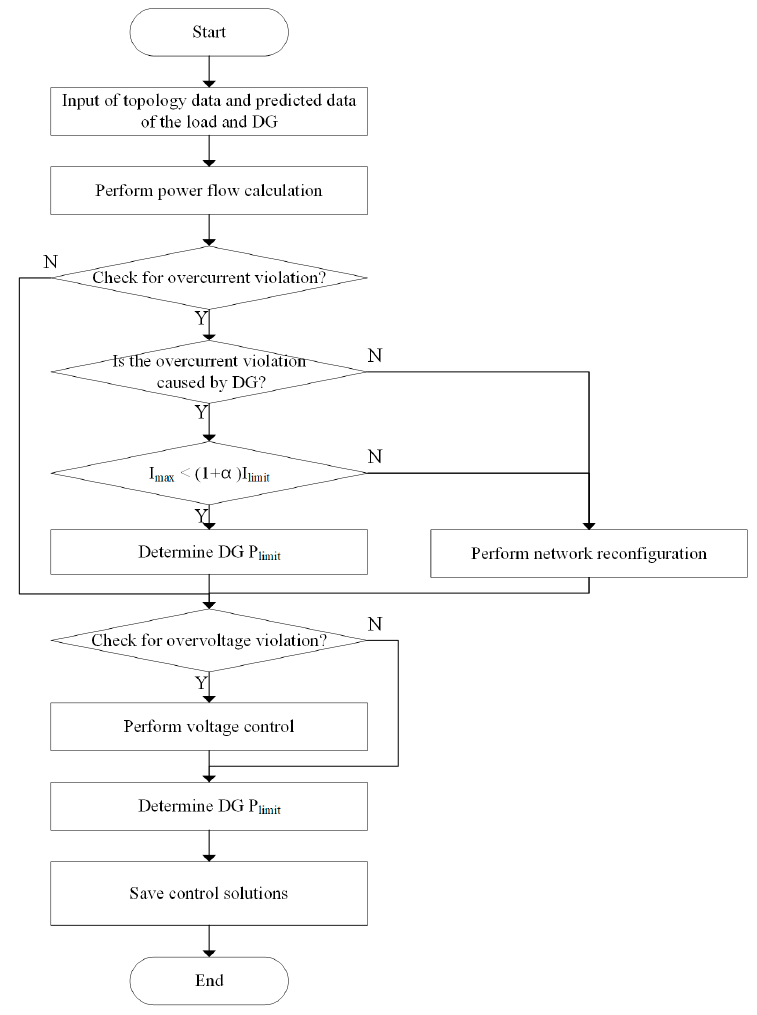
Figure 4. Flowchart of the proposed operational method.